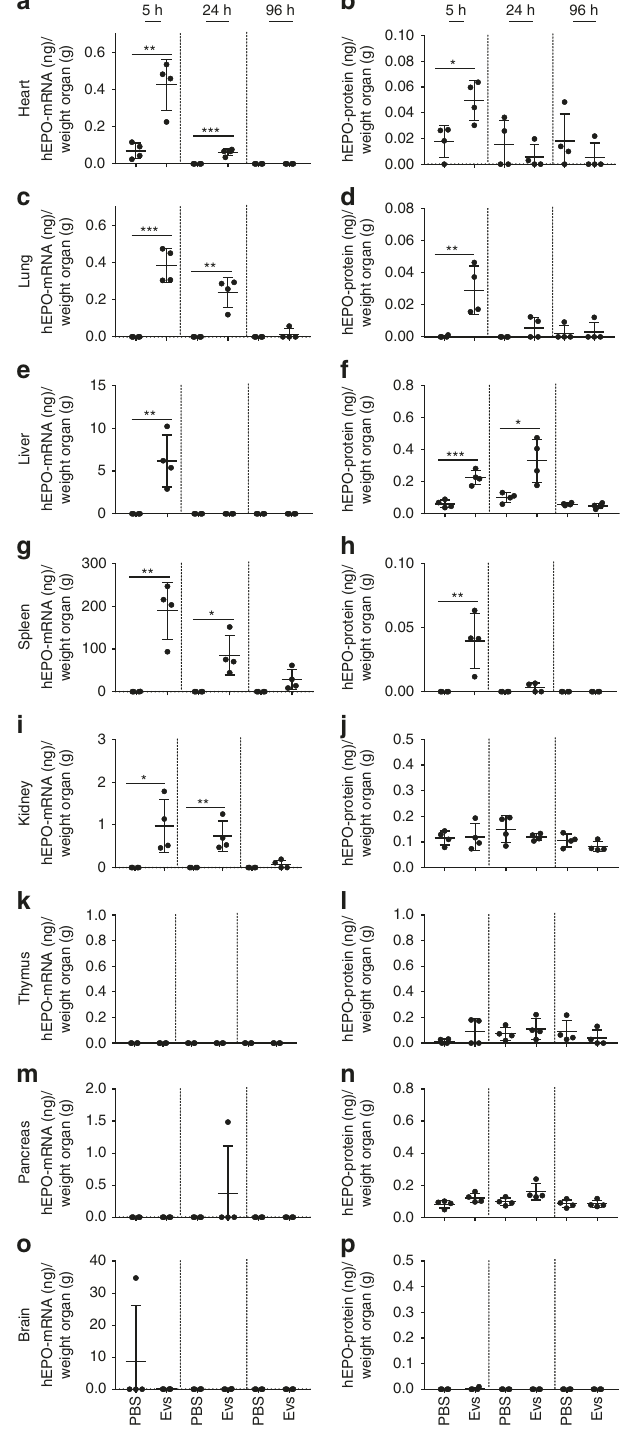
Fig. 4 Quanti fi cation of hEPO mRNA and hEPO protein in mouse organs. Mice were intravenously injected with 100 μ L of mc3-EVs containing 1.5 µ g of hEPO-mRNA (per mouse). At 5, 24, and 96 h after EV injection, the levels of hEPO mRNA and hEPO protein were determined in eight organs by qPCR and ELISA, respectively. a , b Levels of hEPO mRNA and protein in the heart, c , d lung, e , f liver, g , h spleen, i , j kidney, k , l thymus, m , n pancreas, and o , p brain are shown. The highest amount of hEPO protein was detected in the liver, whereas the highest amount of hEPO mRNA was detected in the spleen. Data are presented as the mean (bars) and standard deviation (SD) n = 4 independent animals at each time point. EVs and untreated groups were compared at each time point using the unpaired two-tailed Student ’ s t -test. * p < 0.05, ** p < 0.01, and *** p < 0.001. Source data are provided as a Source Data fi